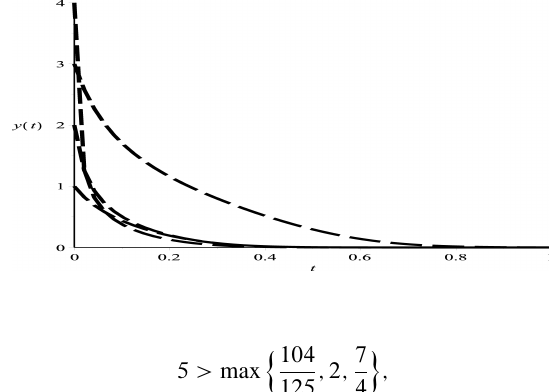
Fig. 2. Dynamic behavior of the second component y.t/ of the solution .x.t/;y.t// of system (59) with the initial